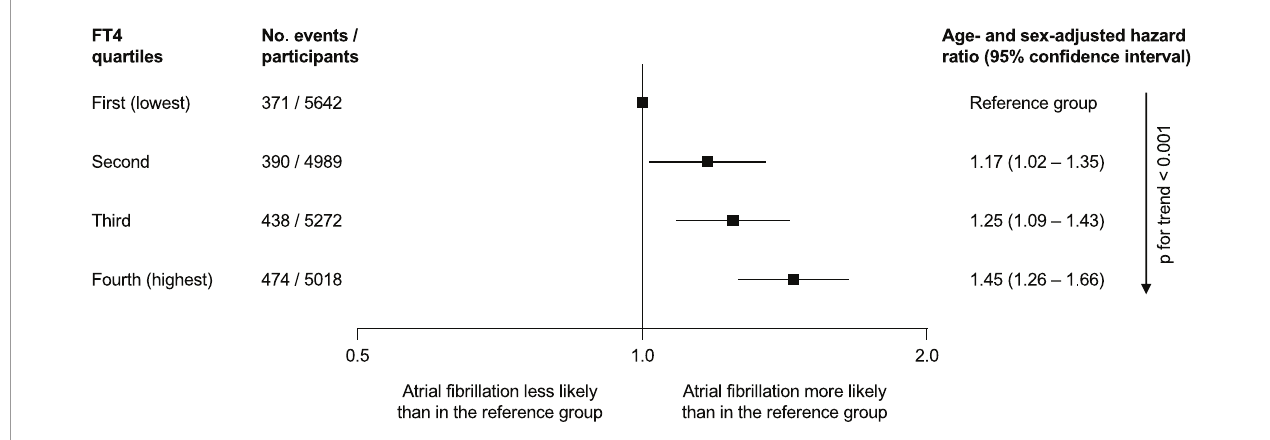
FIGURE 2 | Association of free thyroxine (FT4) quartiles and the incidence of atrial fi brillation in the Thyroid Studies Collaboration, when thyroid-stimulating hormone was within the reference range (0.45 to 4.49 mIU/L) [ fi gure based on data by Baumgartner et